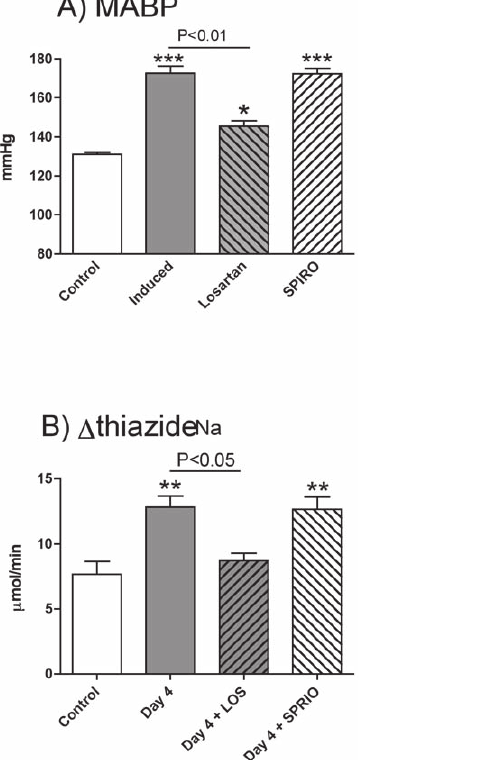
Figure 7. Contributions to hypertension of AT1 and mineral- ocorticoid receptors. A) Mean arterial blood pressure (MABP) and B) hydrochlorthiazide-sensitive sodium reabsorption ( D thiazide Na ) in cyp1a1-Ren2 transgenic rats. Measurements were made in cyp1a1- Ren2 transgenic rats, anaesthetized on day 4 of the experimental regimen. The first control group (n=6; open bars) received vehicle, the second control group (n=8; grey bars) received I3C to induce the Ren2 transgene. Experimental groups received I3C and either losartan (n=6; grey hatched bars) or spironolactone (n=6; open hatched bars). Data are means 6 SE and statistical comparisons were made using ANOVA with Bonferroni post-test. ***P , 0.001, **P , 0.01, *P , 0.05 versus the non-induced control group and other comparisons as